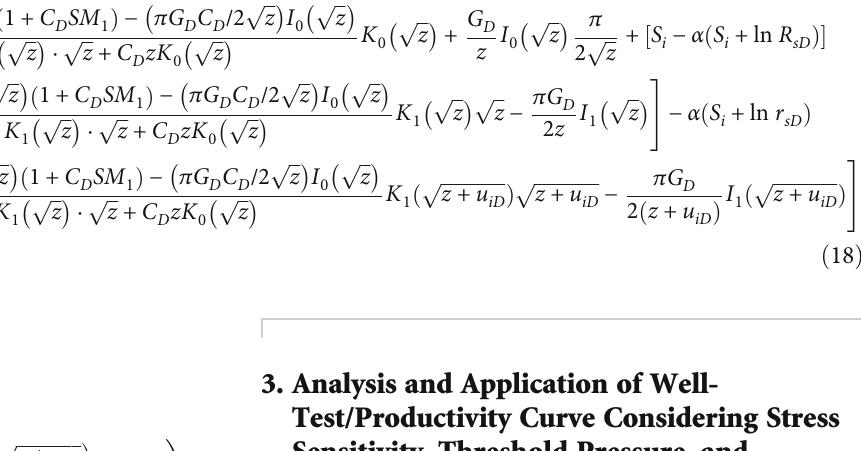
ffiffiffiffiffiffiffiffiffiffiffiffiffi p z + u ð